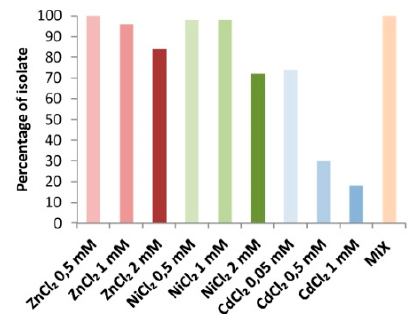
Figure 4. Characterization of the bacteria collection for metal tolerance. Percentage of strains tolerant to ZnCl 2 , NiCl 2 and CdCl 2 at three di ff erent concentrations and to the MIX of metals (30 µ M ZnCl 2 , 1.7 µ M NiCl 2 and 0.1 µ M CdCl 2